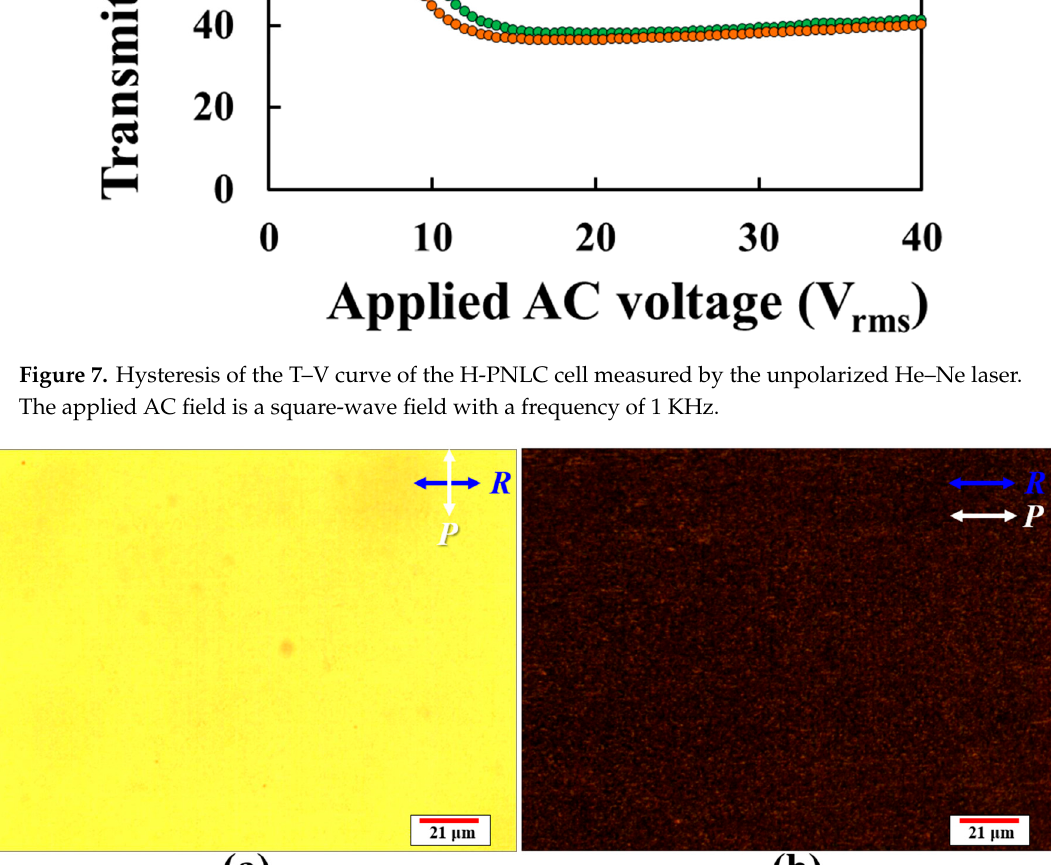
Figure 8. Microscopic images of the H-PNLC cell applied with 18.5 V rms under the configurations consistent with those of ( a ) the red and ( b ) the blue curves in Figure 6 using a separate experiment. Blue ( R ) and white ( P ) arrows represent the rubbing directions of the two substrates of the H-PNLC cell and the polarization direction of the incident LP backlight of the microscope, respectively.